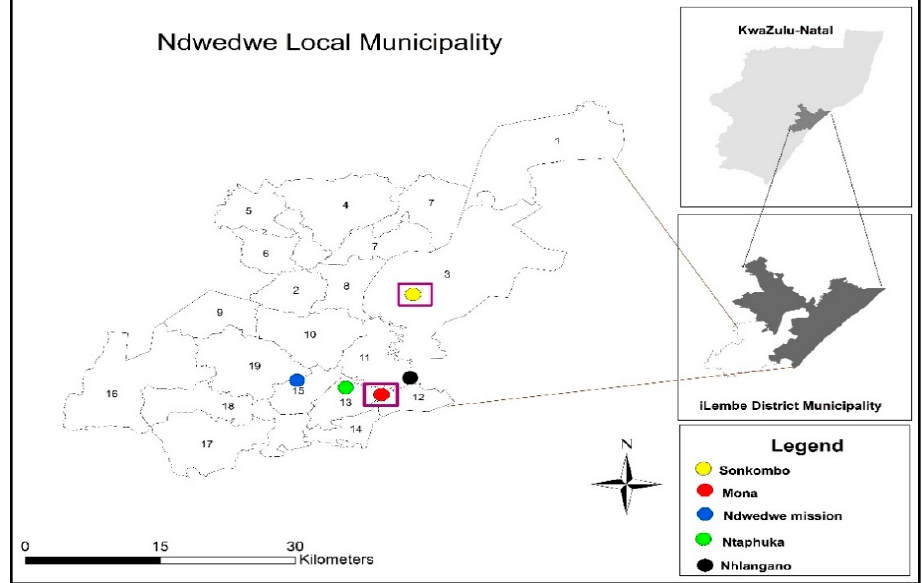
Figure 1. Map showing the location of Mona and Sonkombo in Ndwedwe Local Municipality.